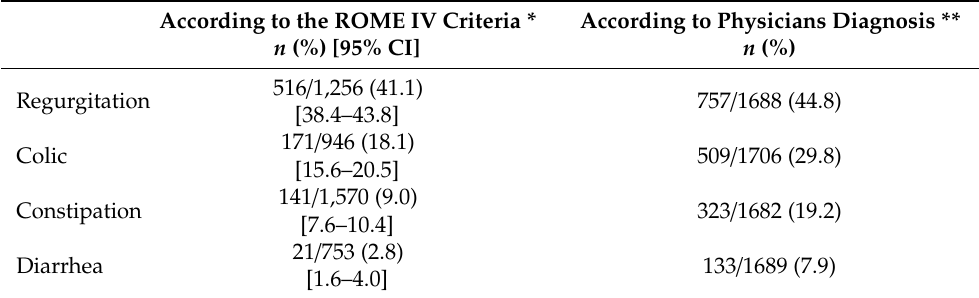
Table 3. Frequency of functional gastrointestinal disorders in infants.